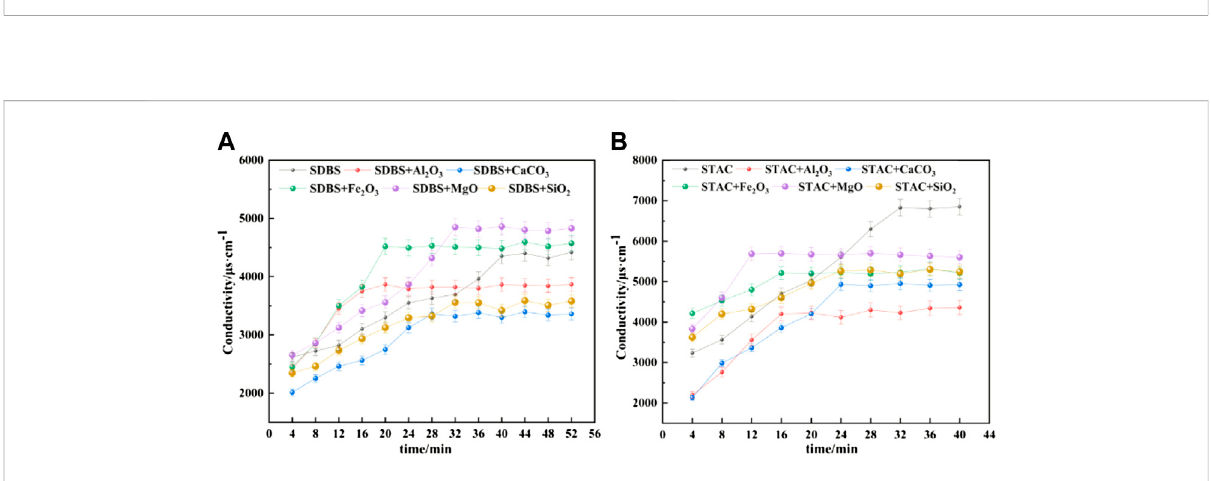
FIGURE 15 Changeofconductivity oftheemulsi fi edasphalt-aggregate systemswith time.Whentheconductivityreachesastable value,demulsi fi cationis said to have occurred. (A) SDBS emulsi fi ed asphalt. (B) STAC emulsi fi ed